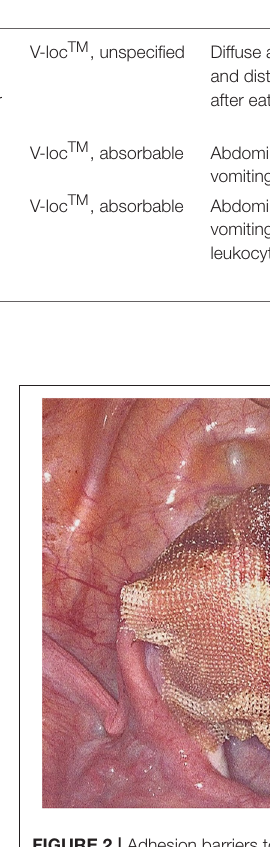
FIGURE 2 | Adhesion barriers to avoid direct bowel contact with the barbed suture.